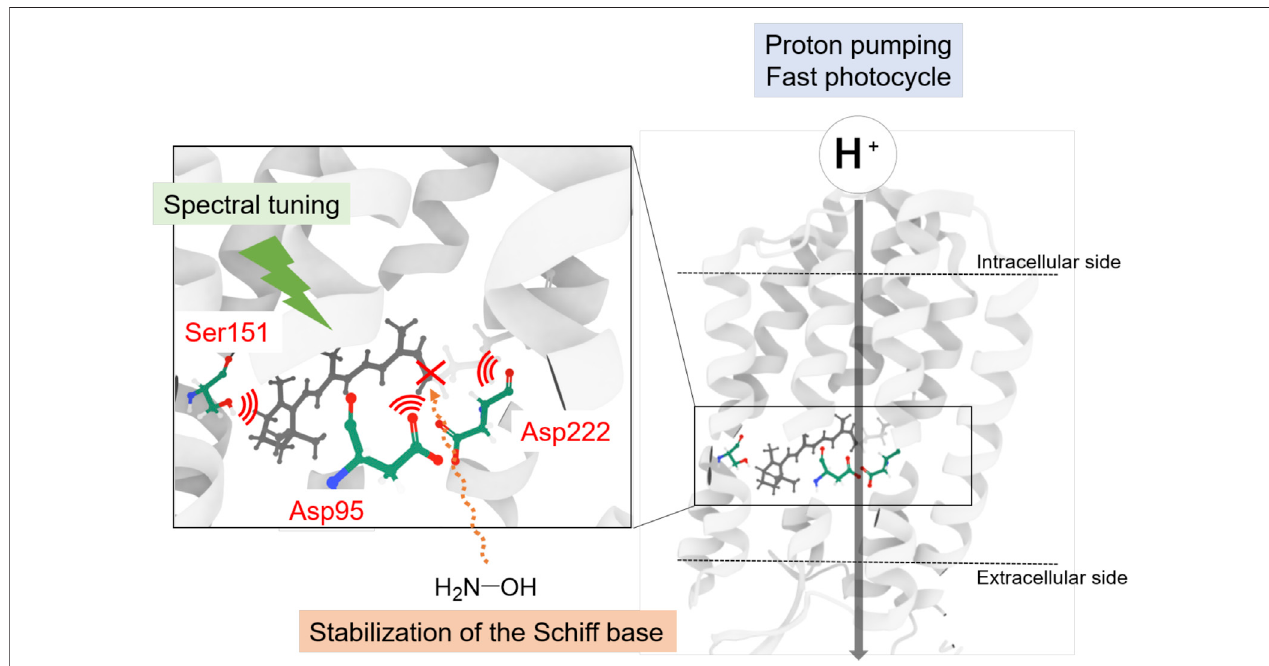
FIGURE 6 | Schematics of the chromophore binding cavity of AR3. The natural protein AR3 was optimized by nature to have a tuned absorption maximum, a resistance against bleaching of the chromophore.